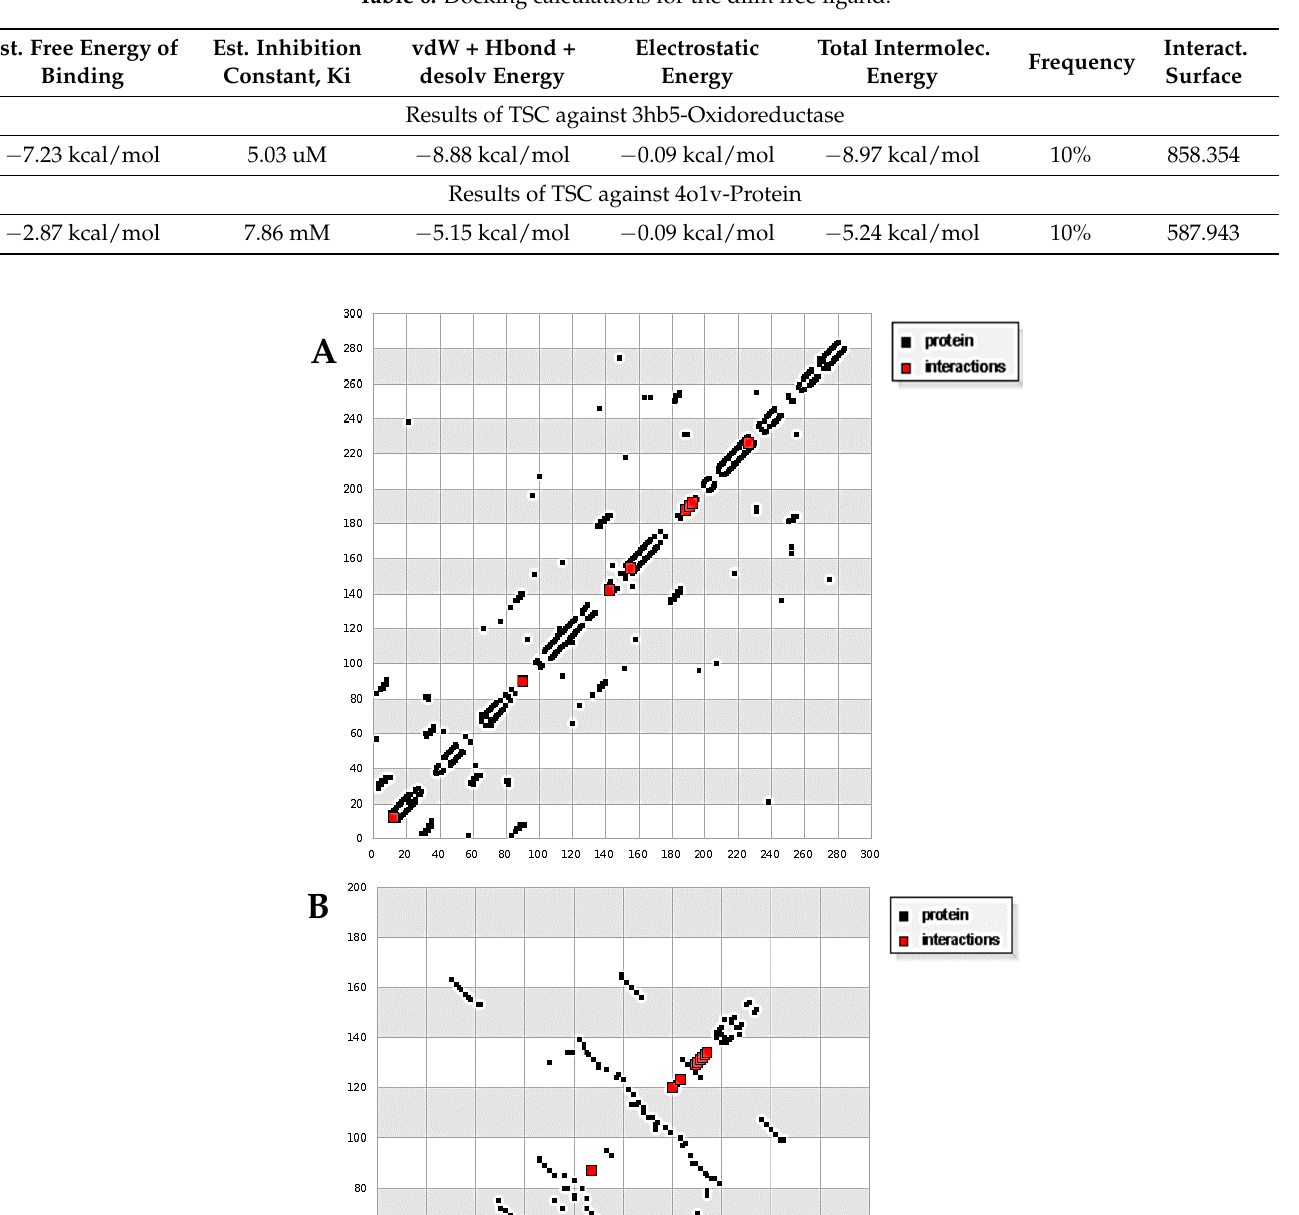
Table 6. Docking calculations for the diim free ligand.